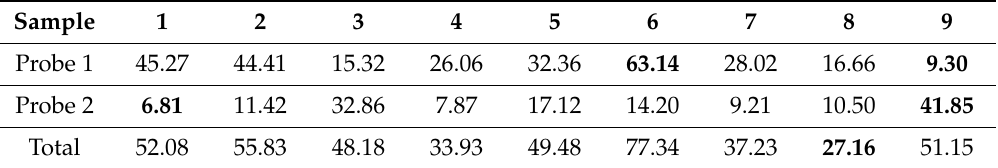
Figure 9. L* , a* , b* clouds for samples retrieved from probe 1 (top row) and probe 2 (bottom row). The green and red colors represent pigment pixels and the grey color represents the white pixels. The k-means algorithm was able to correctly classify 100% of the pixels from both ground truth sets as either pigment or white pixels. This result highlights the confidence in the information shown in Table 5, as a figure of merit for the di ff erent cleaning methods used for both probes. Table 5. Percentage of automatically segmented white areas over the full area studied for all the samples and probes. The higher this value is the worse the performance of the cleaning method. The bottom row shows the total of the two previous